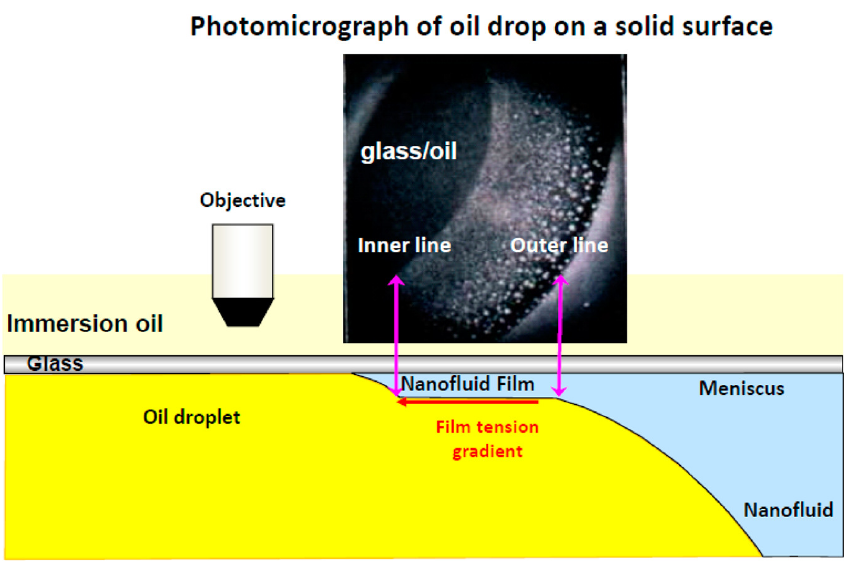
Figure 6. Photomicrograph taken using reflected-light interferometry depicting the inner and outer contact lines and the nanofluid film region. Adapted with permission from [138]. Copyright (2012) American Chemical